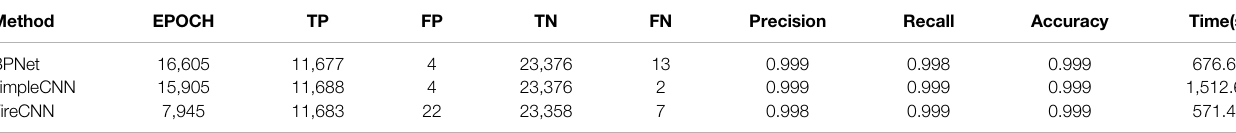
TABLE 4 | The results of deep learning